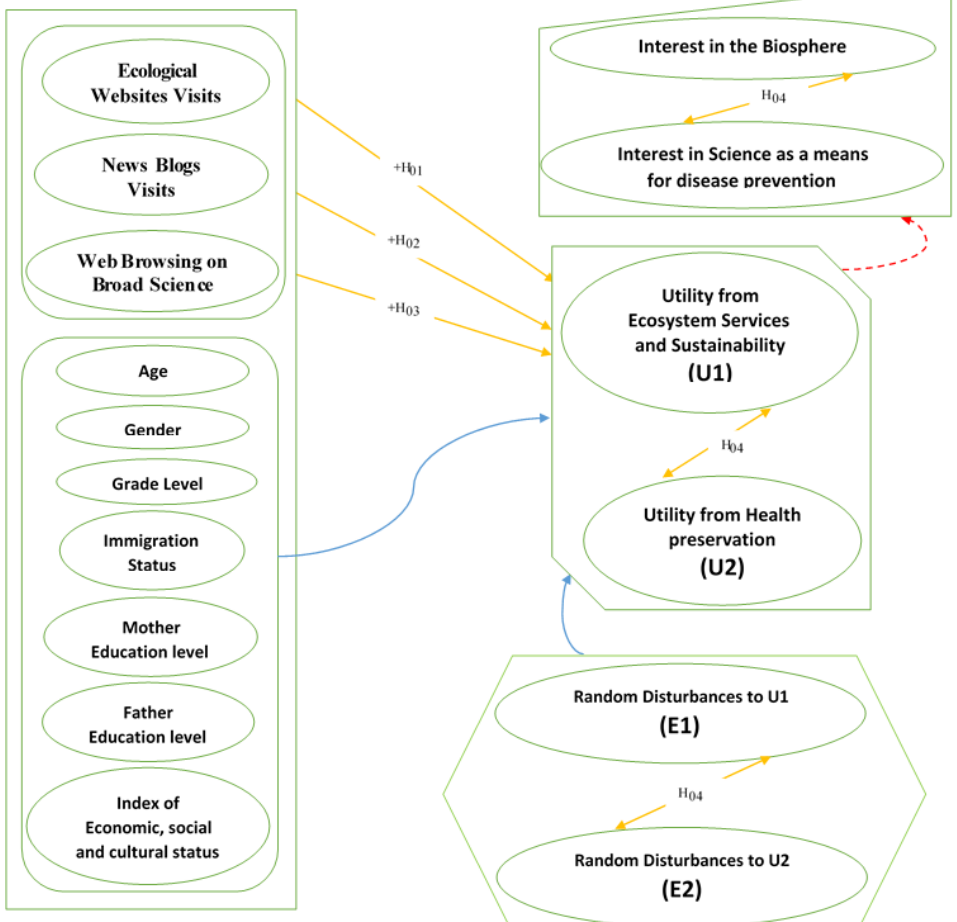
Figure 1. Random Utility-Based Conceptual Framework of Youths’ Planetary Health Interest. Note that the orange links are the tested relationships in the present analysis; The blue links are structural relationships; while the dotted red link is a measurement relationship linking latent utilities to revealed interests in health and the